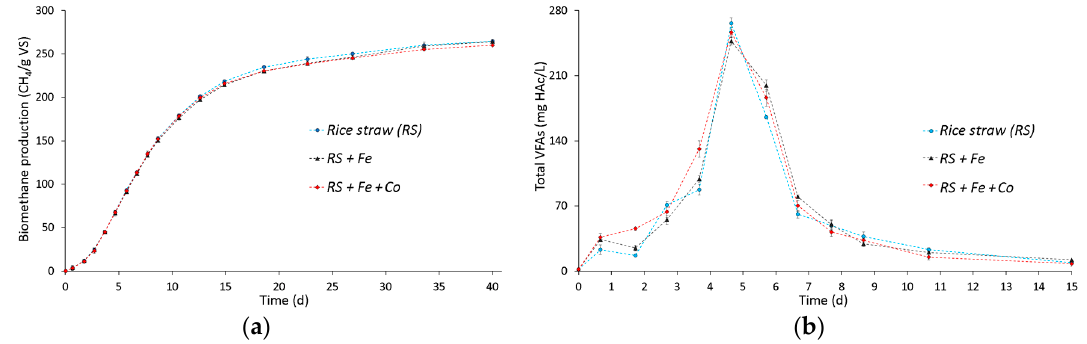
Figure 1. Biomethane production ( a ) and VFA accumulation ( b ) during the AD of rice straw i) without trace element supplementation, ii) with added Fe alone, and iii) with a cocktail of Fe + Co.